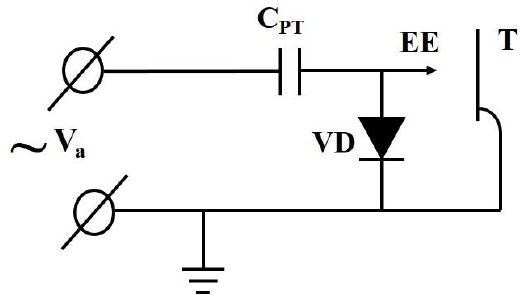
Figure 2. The equivalent scheme of the returning of the charge. The sinusoidal high voltage of amplitude 𝑉 𝑎 is produced at the high voltage electrode of the piezoelectric transformer, 𝐶 𝑃𝑇 is the output capacity of the piezoelectric transformer, VD is the vacuum diode, EE is the emitter of electrons, and T is the target.